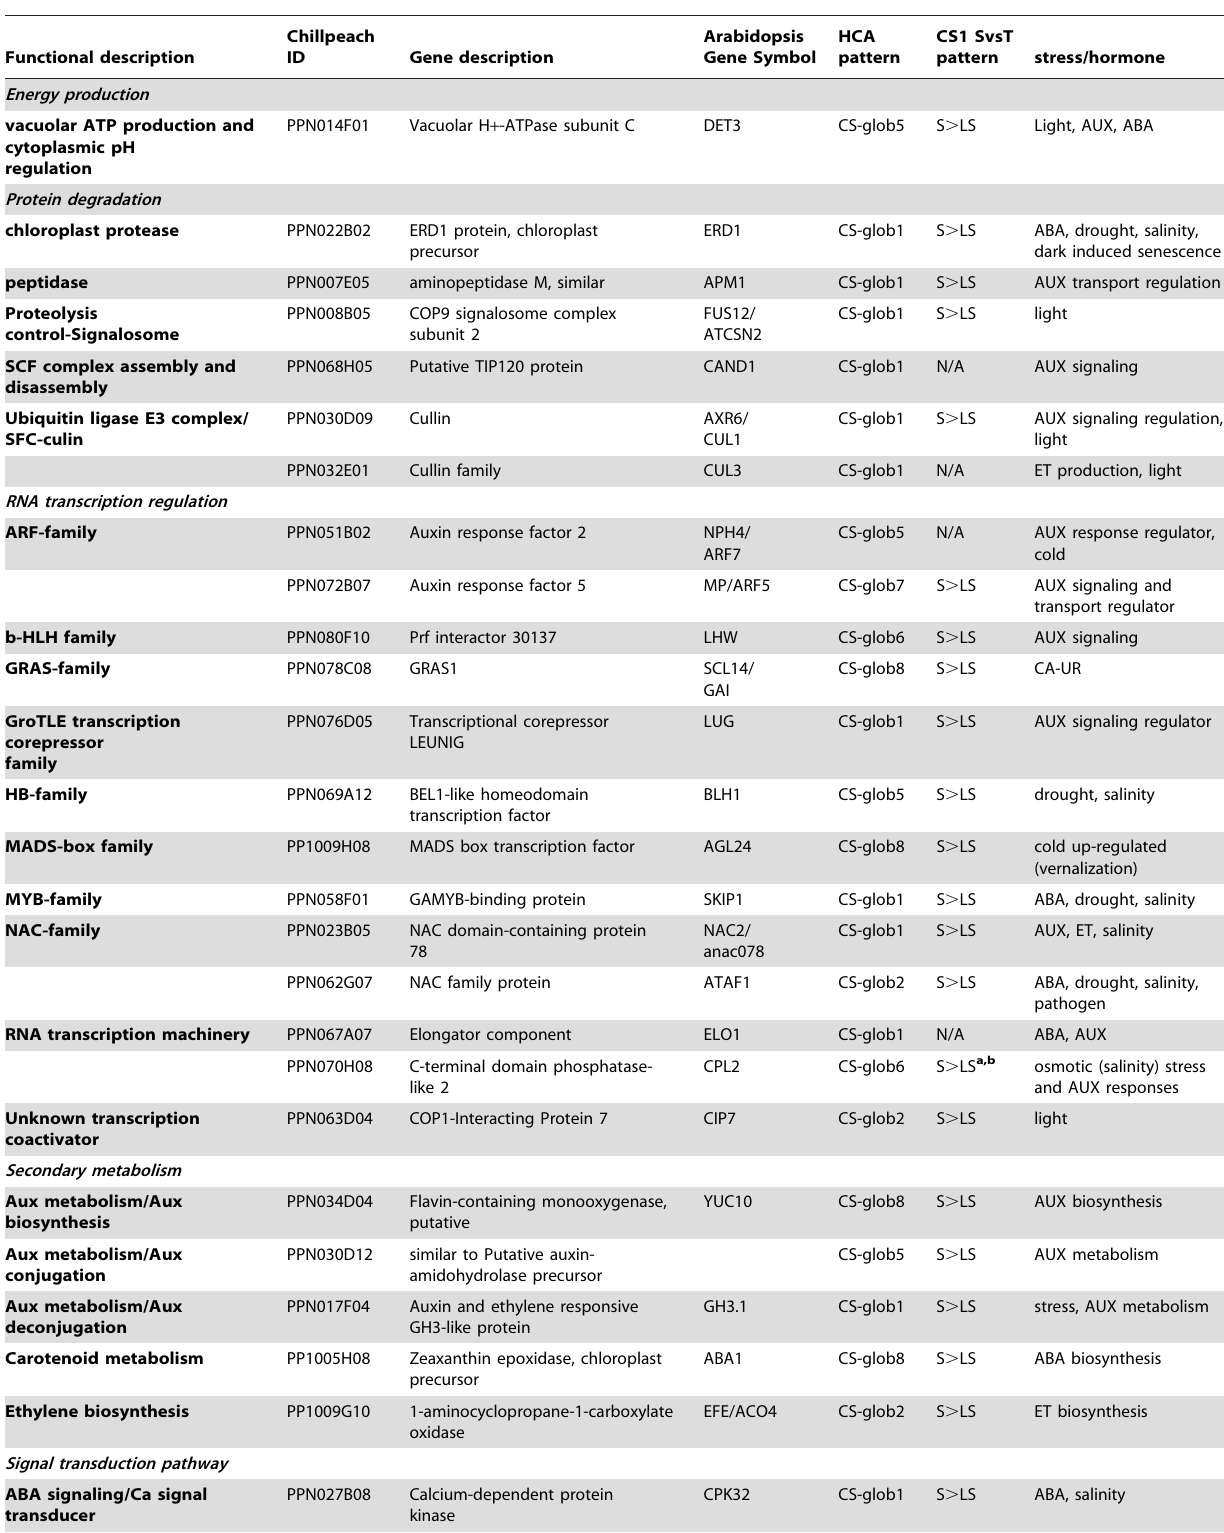
Table 3. Expression Regulators and Signaling Elements with High Expression in High Sensitive Fruits at One Week of Cold Storage with stress and hormone related